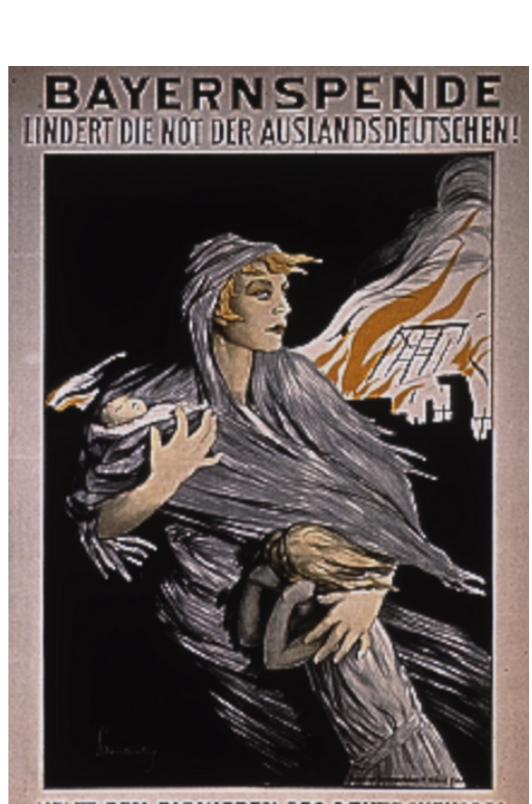
"The NSDAP is the support of all Germans living in the east," undated. Poster Collection, Hoover Institution Archives, GE 1052.